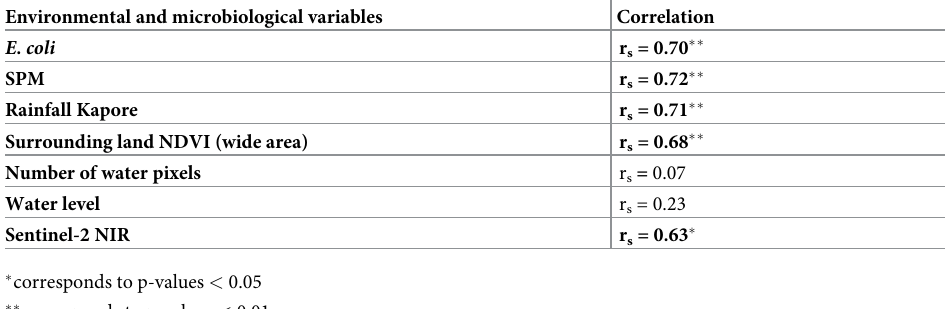
Table 2. Correlation coefficients obtained by regressing diarrhea incidence and E . coli , and diarrhea incidence and environmental variables over the period March 2018-March 2019.